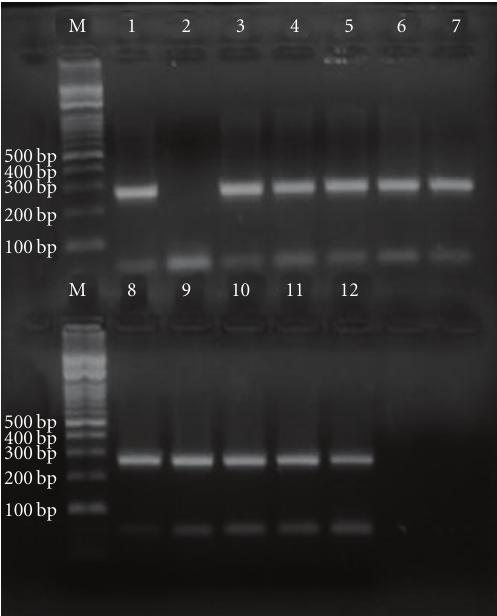
Figure 2: The 267 bp of amplification product of rrnS-PCR with the Cest3 and Cest5 primers M: Marker, 1: Positive control (gDNA of an adult T. hydatigena ), 2: Negative control (distilled water), 3– 12: Ten cystic samples collected from the liver.